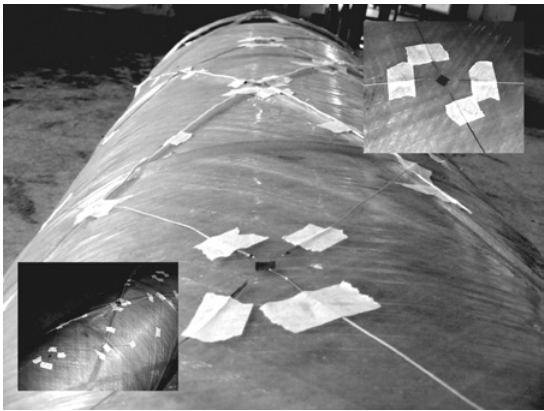
and circumfer- x